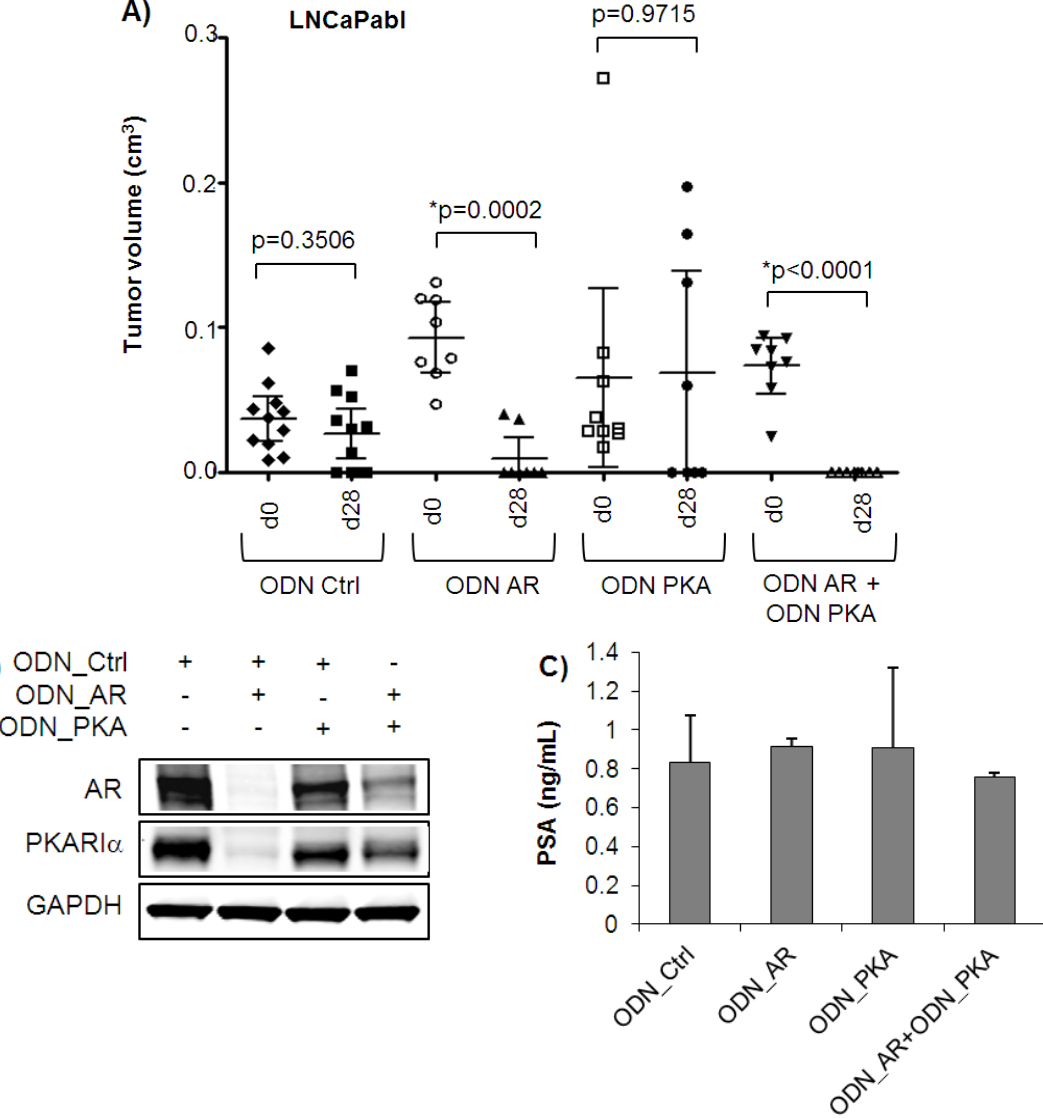
Figure 5. Effects of ODN_AR and ODN_PKA either alone or in combination in LNCaPabl tumors in vivo . For establishment of castration-resistant LNCaPabl tumors, mice were castrated one week before tumor cell injection. ( A ) Administration of ODNs was started at day 0 (d0) and tumors were harvested at day 28 (d28). Tumor volumes were determined by caliper measurement and displayed individually. In addition, mean tumor volume ± S.E.M was indicated. Significant reduction of tumor volumes was detected after treatment with ODN_AR alone ( * p = 0.0002, n = 8), as well as in combination with ODN_PKA ( * p < 0.0001, n = 8, paired t -test). Neither the ODN_Ctrl ( n = 11) nor the ODN_PKA ( n = 8) significantly affected tumor growth; ( B ) Expression of AR and PKARI α was determined by Western blotting in tumors harvested after one week of treatment. GAPDH was used as internal control; ( C ) For PSA measurements, blood was taken at the end of treatment, and serum PSA levels were determined by Advia CentaurXP Immunoassay System. Values were indicated as ng/mL ±